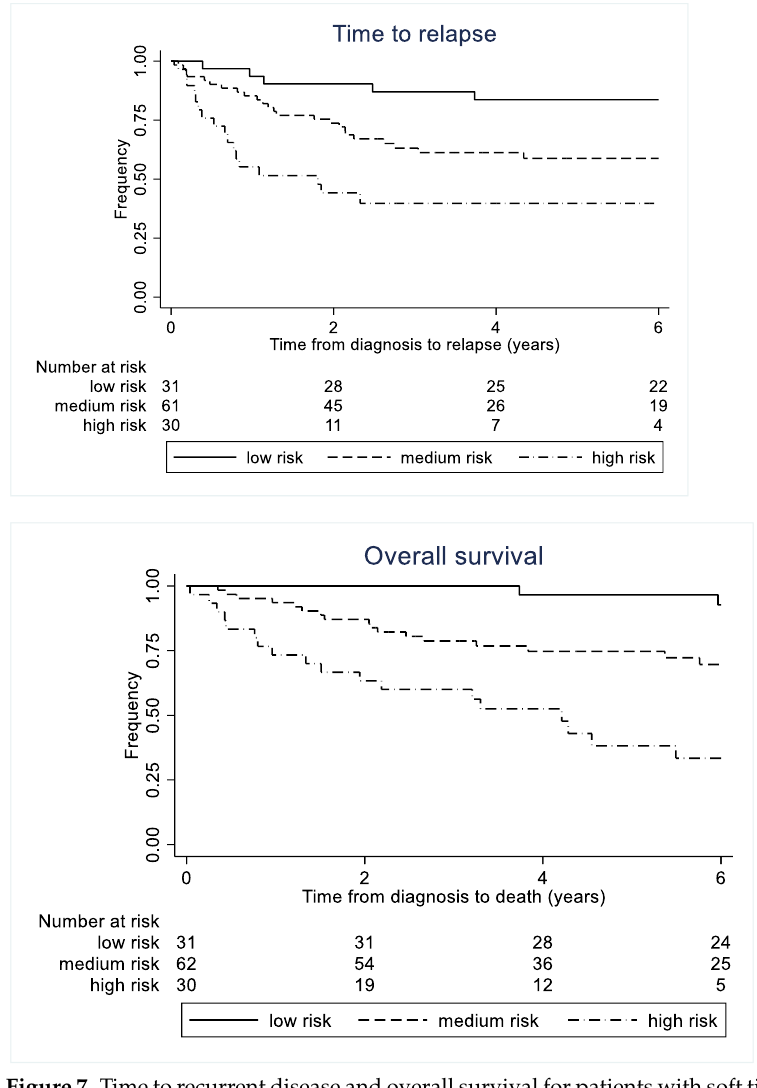
Figure 7. Time to recurrent disease and overall survival for patients with soft tissue sarcoma according to serum biomarker profile. A total of 122 patients were included in the recurrent disease analysis; 123 patients were included in the overall survival analysis because a few patients did not have all the measurements included in the profile. In the analysis, 46 out of 122 patients (38%) experienced a disease relapse (local or metastatic). Five out of 31 patients (16%) in the low-risk group had a local relapse. In the intermediate-risk group, 24 out of 61 patients (39%) had a relapse; of these, 10 were local relapses and 14 were metastatic relapses. In the high-risk group, 17 out of 30 patients (57%) had a metastatic recurrence. Based on the Akaike information criterion (AIC) and Harrell’s concordance index (Table 3), the addition of the profile to a prognostic model containing the known prognostic factors age at diagnosis and tumour size significantly improved the